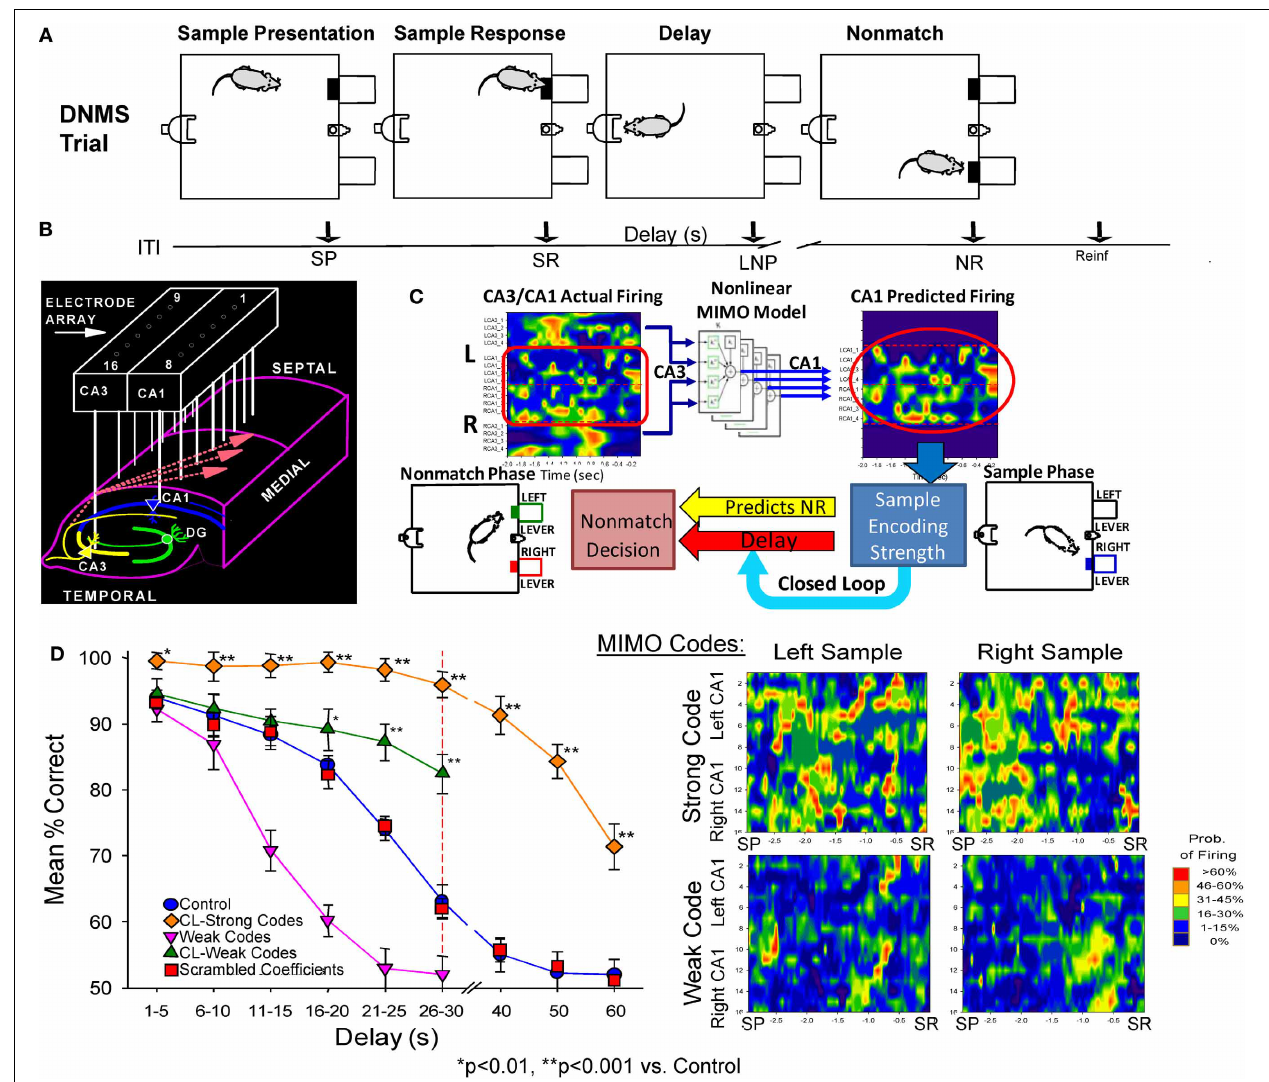
FIGURE 1 | Delayed non-match to sample (DNMS) task, MIMO model and associated hippocampal ensemble activity. (A) DNMS Trial Diagram. Sample lever presentation (SP) and Sample response (SR) are followed by a variable delay interval which required a nosepoke (NP) in a photocell on opposite wall. The Non-match phase began after delay timeout, with both levers presented simultaneously for reward contingent Non-match Response (NR) on the lever opposite the SR position. Correct non-match responses produced 0.2ml of water delivered to the trough between the levers. Timeline below shows sequence of task phases: ITI–intertrial interval; SP–Sample Lever presentation; SR–Sample response; Delay–Delay interval; LNP–last required nosepoke during Delay; NR–Non-match (decision) response; Reinf.—Delivery of water reward. (B) Hippocampal recording array: two rows of 8 stainless steel 20 µ m wires positioned longitudinally within hippocampus at 200 µ m intervals for each electrode pair in CA3 and CA1 cell layers. Arrays were implanted bilaterally in both hippocampi providing a total of 32 indwelling chronic electrodes per animal. (C) Heatmap display (left) showing online array monitored hippocampal ensemble single neuron (actual firing) activity. Low-to-high (blue-to-red) firing rates are indicated at the separate CA3/CA1 locations on the array (B) during the occurrence of the SR (time 0.0s). Schematic of non-linear MIMO model: Spike trains X 1 –X 8 recorded from CA3 electrodes (CA3 input) on the hippocampal array (left) are input to the model and used to predict CA1 firing across the other 8